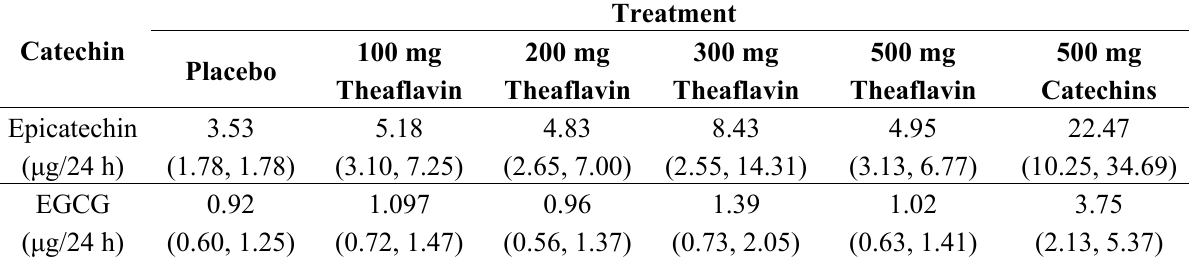
Table 3. Treatment related changes in urinary epicatechin and epigallocatechingallate (EGCG) levels in all individuals as measured by targeted